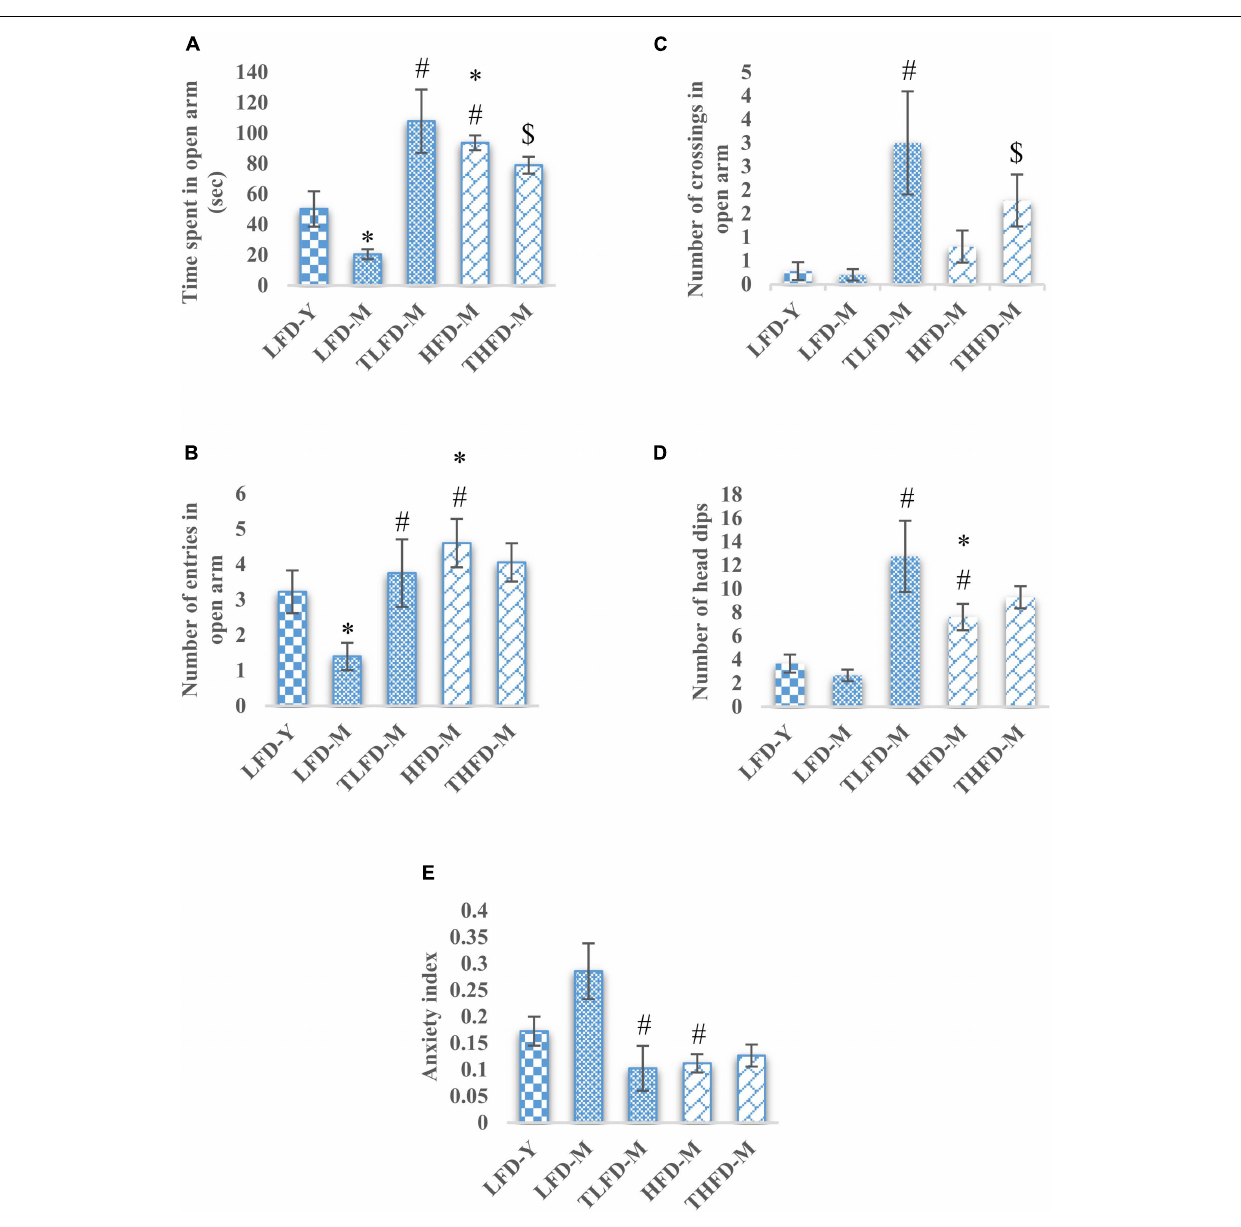
FIGURE 1 | Tinospora cordifolia stem powder (TCP) supplementation suppressed the anxiety-like behavior in middle-aged acyclic female rats. Histogram representing (A) average time spent in open arm, (B,C) number of entries and crossings of rats in open arm, (D) number of head dips among different groups of middle-aged acyclic female rats. (E) Anxiety index. Values are presented as mean ± SEM. ∗ p ≤ 0.05 LFD-Y vs. LFD-M and HFD-M; # p ≤ 0.05 LFD-M vs. HFD-M and TLFD-M; $ p ≤ 0.05 HFD-M vs.